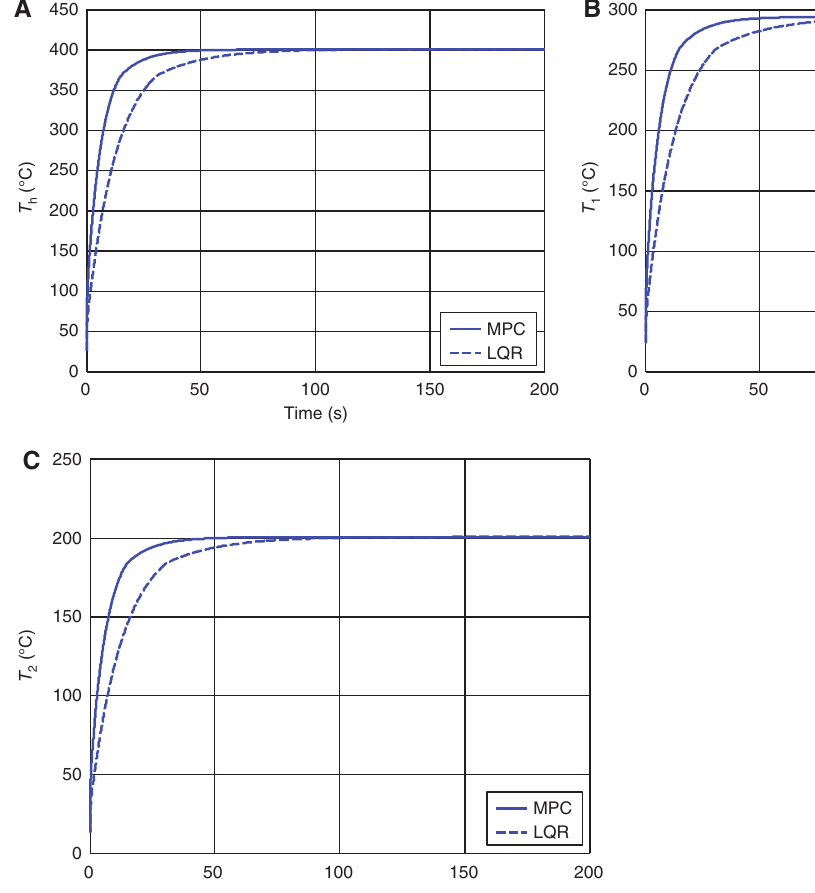
, (B) T , and (C) T h 1 2